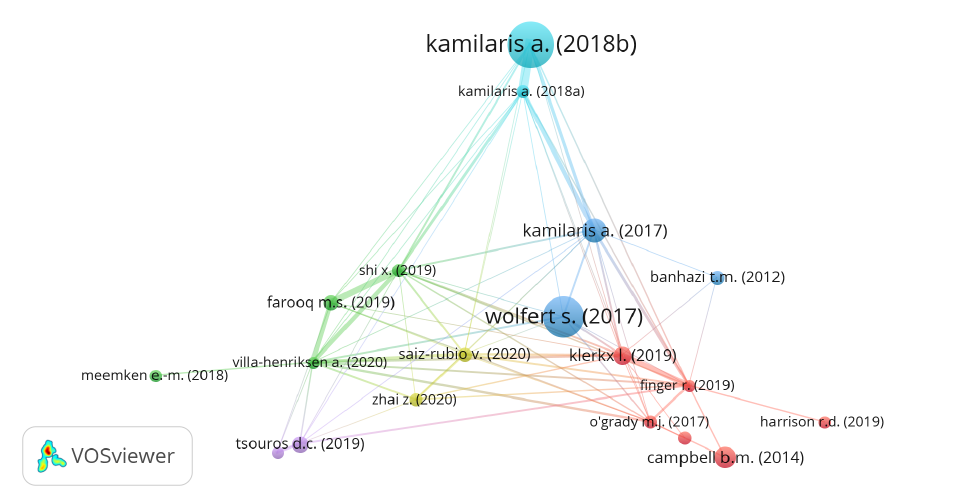
Figure 3. Network